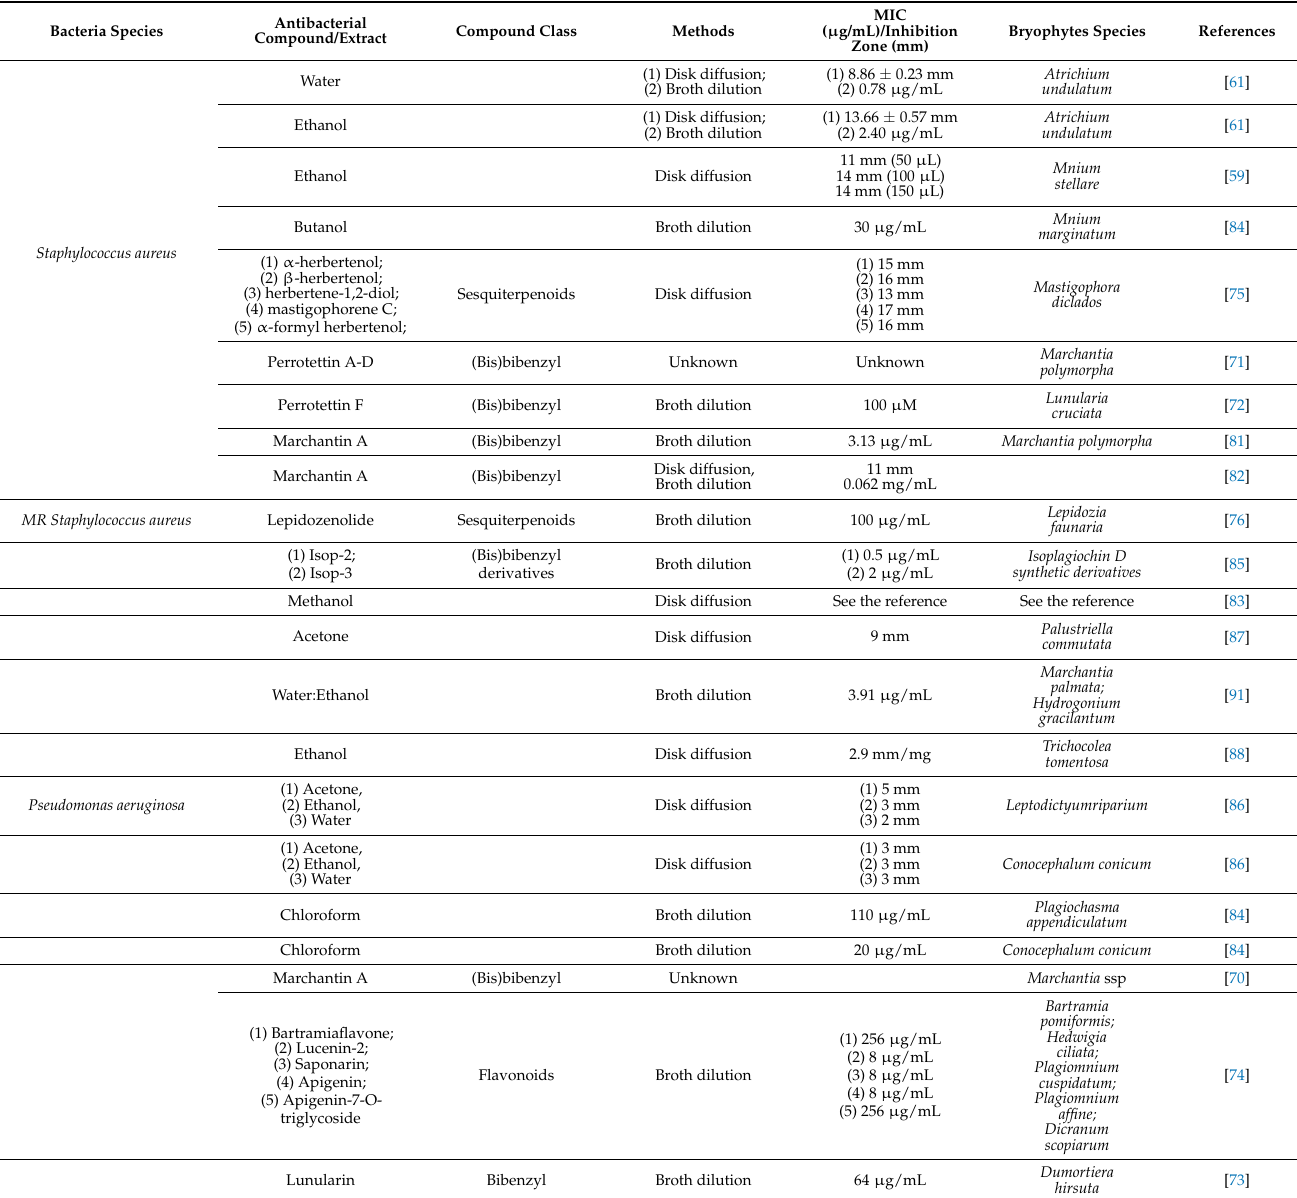
Table 3. List of the selected bacterial species and related antibacterial extracts and